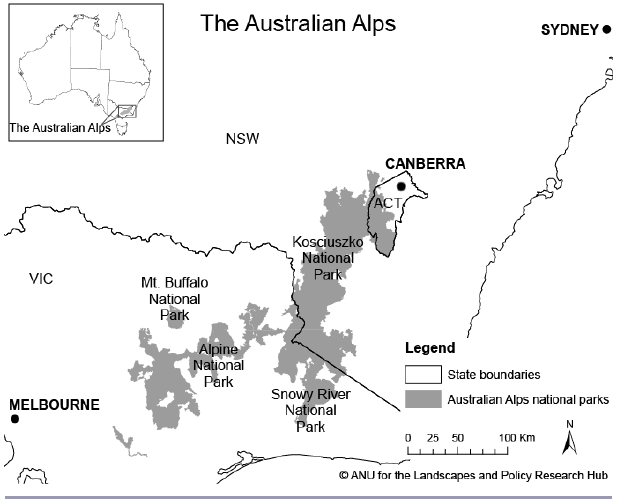
Fig. 1 . Major protected areas in the Australian